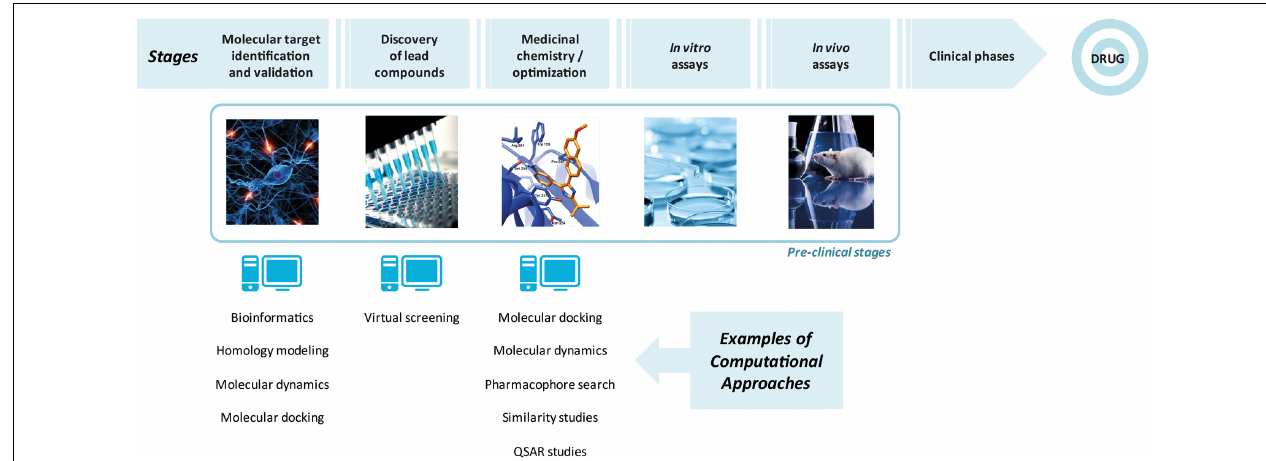
FIGURE 1 | Main steps involved in drug design, highlighting the use of computational